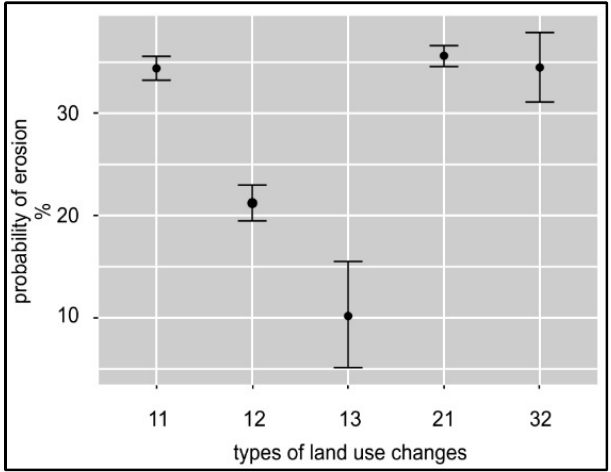
Figure 9. Category of land use change types, 11—strong intensification, 12—moderate intensification, 13—weak intensification, 21—preservation, 32—moderate extensification.